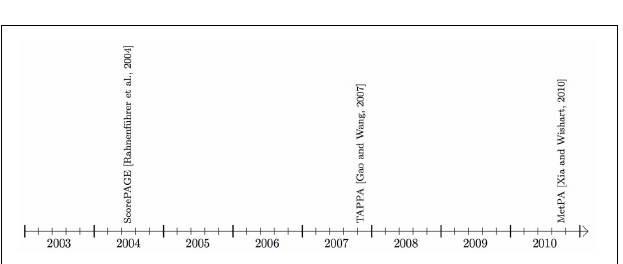
FIGURE 3 | Timeline showing when the surveyed pathway analysis tools, working mainly with signaling pathways, became available (this time may be different from publication time shown in Table 1). Some of the methods use additional interaction information that may be from an in-house or public gene/protein interaction knowledge base. BAPA-IGGFD (Zhao et al., 2012) and TBScore (Ibrahim et al., 2012) acronyms were assigned to the respective methods, in this manuscript, for ease of reference. The commercial tools, Pathway-Guide and MetaCore are not included in this figure.